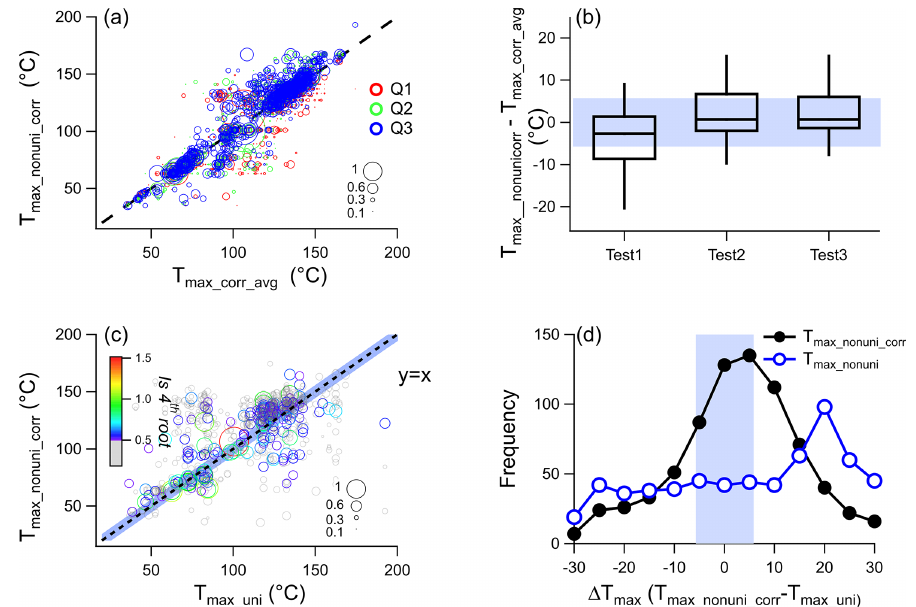
Figure 9. (a) Comparison of T max_nonuni_corr from the three duplicate tests and their average ( T max_corr_avg ). (b) Distribution of the differ- ence between the three triplicate tests and the T max_corr_avg . (c) Comparison of T max from the corrected non-uniform ramping and uniform ramping protocol ( T max_uni ). (d) Histogram of (cid:49)T max between T max from the uniform ramping protocol ( T max_uni ) and non-uniform with ( T max_nonuni_corr ) or without ( T max_nonuni ) correction. The size of symbols in panels (a) and (b) is proportional to the fourth root of the in- tegrated signal intensity. The fourth root of the signal intensity < 0.5 is shown in gray. The uniform ramping protocol test and three duplicate non-uniform ramping protocol tests were conducted for the same 24h quartz filter (23 to 24 November). The shaded areas in panels (b) , (c) , and (d) represent the T max variation ( ± 5.7 ◦ C) from the duplicate